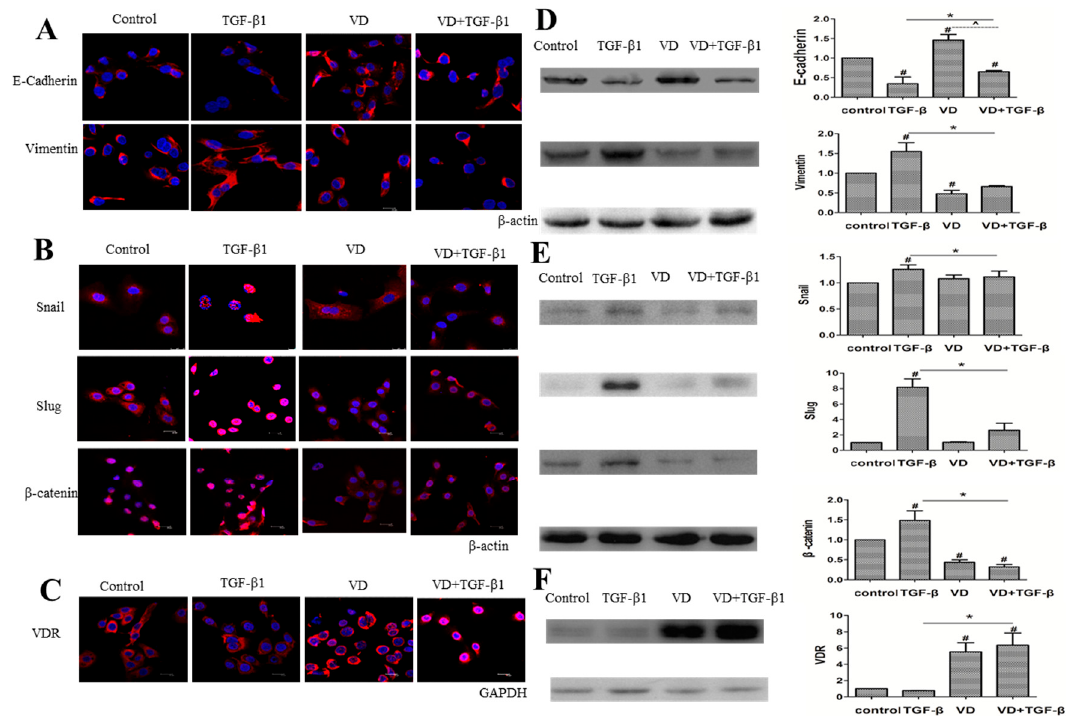
Figure 4. 1 α ,25(OH) 2 D 3 regulated the expression of EMT-related markers in SKOV-3 cells exposed to TGF- β 1. ( A – C ) representative pictures of indicated proteins E-cadherin, Vimentin, Snail, Slug, β -catenin and VDR were captured by confocal laser scanner microscopy (CLSM). Nuclear DNA was visualized by DAPI staining. 200× magnification; ( D – F ) Left : Western blot analysis of the indicated proteins in SKOV-3 cells. β -actin or GAPDH served as a loading control; Right : the level of the indicated protein was quantified with gray value. The data represent the Mean ± SD. # p < 0.05 versus negative control, * p < 0.05 versus TGF- β 1-treated group, and ^ p < 0.05, VD + TGF- β group versus VD group. VD